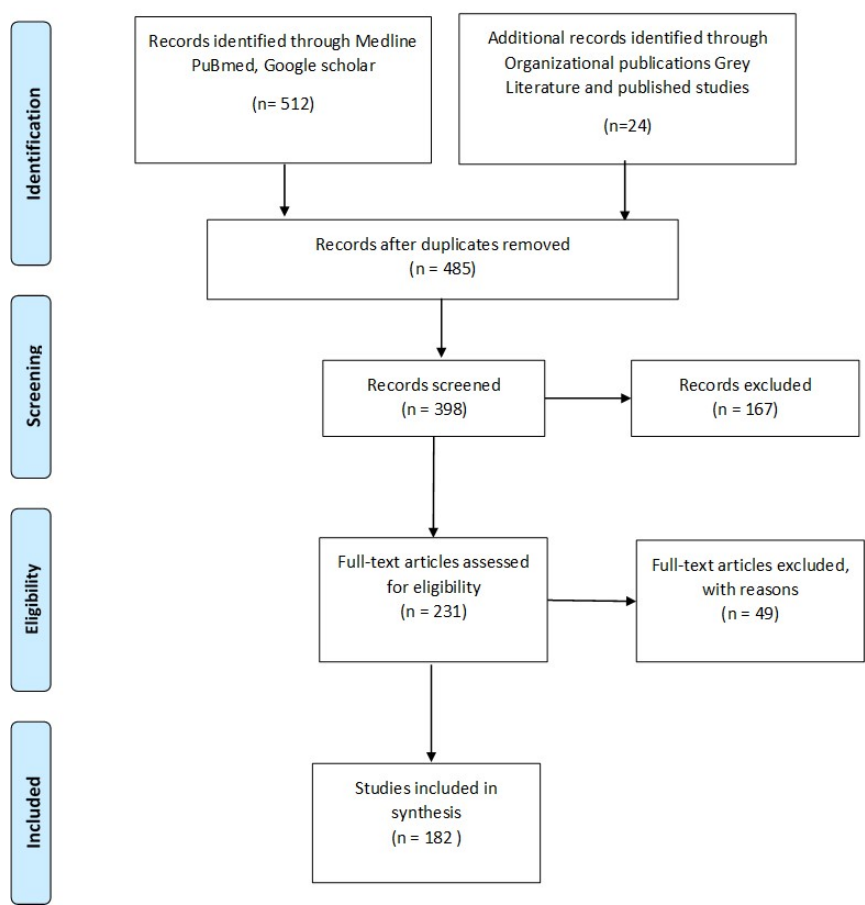
Figure 1. PRISMA flow diagram of the search.